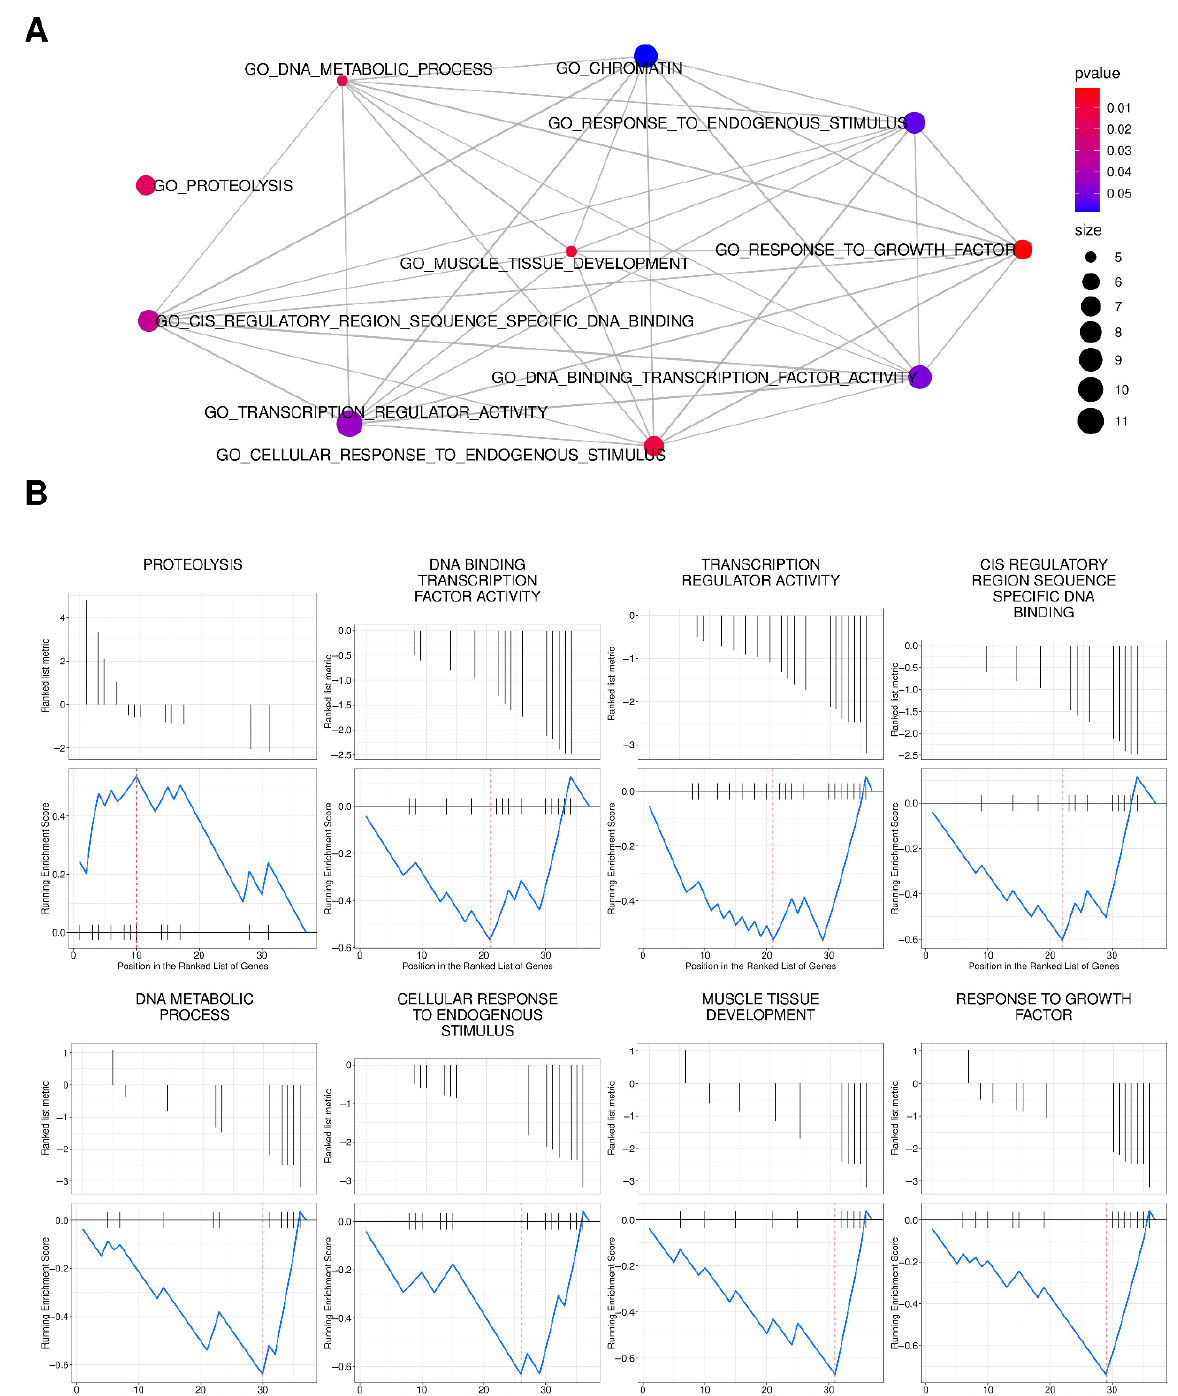
Figure 4. Gene Set Enrichment Analysis (GSEA) for Differentially Expressed Genes (DEGs) in the Gene Ontology (GO) database. ( A ) Biological network of the most represented GO terms, including the 37 detected DEGs in our study. Plots are represented as linked dots colored by p -value and sized by the number of involved genes; ( B ) GSEA plots indicate the DEGs’ distribution for each pathway. Blue lines represent the fluctuation of the Enrichment Score for each selected pathway indicating which one was upregulated (above the horizontal black bar) or downregulated (below the horizontal black bar). When performing the ROC curves for the 37 DEGs detected in our study, we ob- served that all six upregulated genes showed AUC > 0.77 ( IL1A , MCM2 , MMP1 , MMP12 , SFN and VEGFA ) and presented good accuracy in discriminating TT from NNT groups as shown in Figure S2.